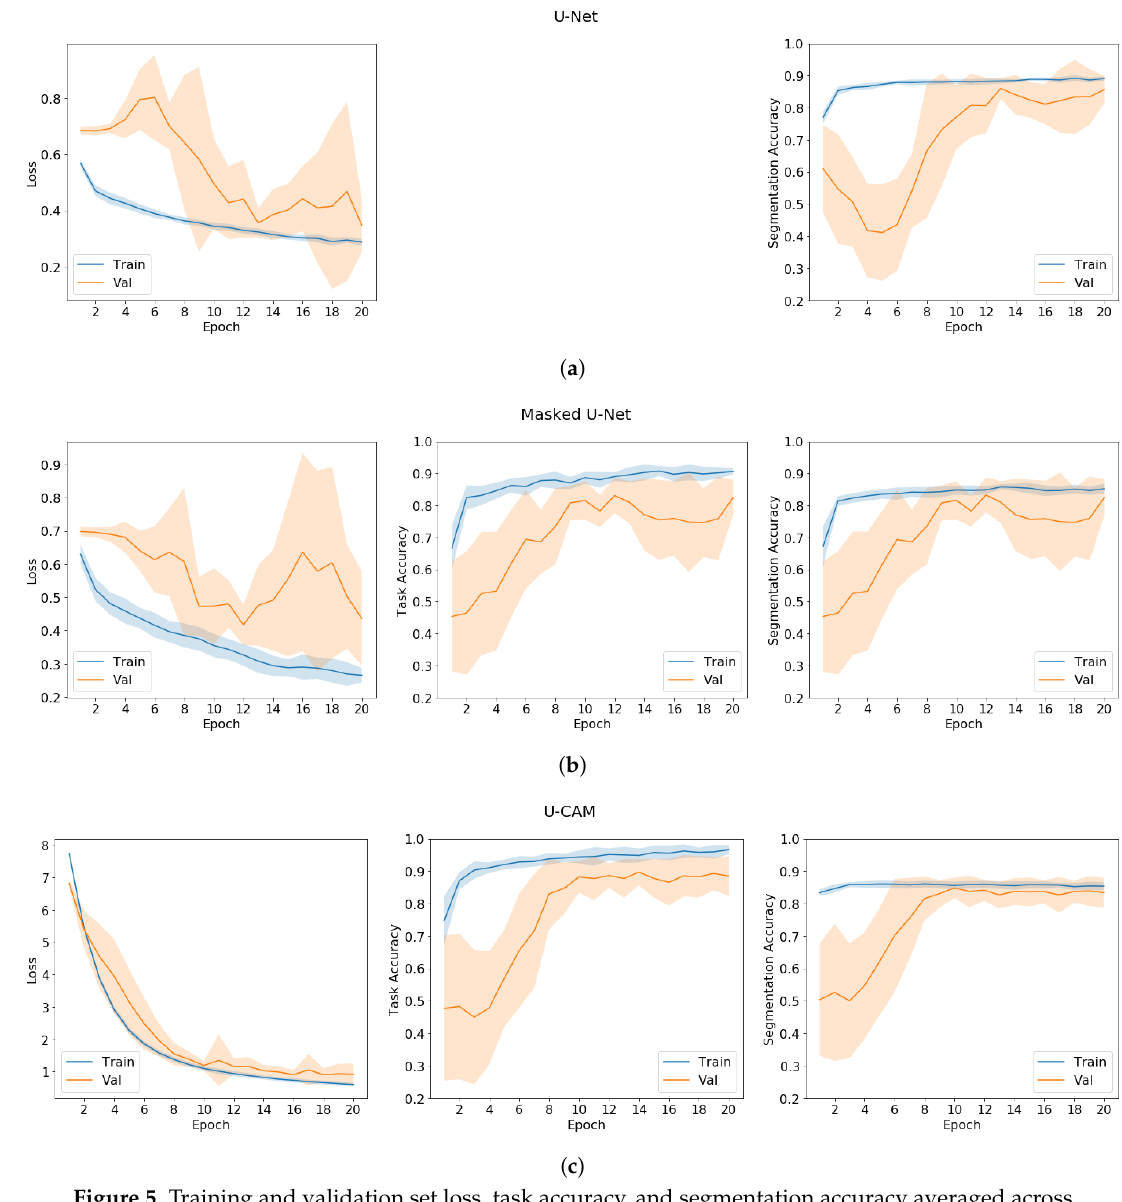
Figure 5. Training and validation set loss, task accuracy, and segmentation accuracy averaged across 10 runs of 20 epochs at n = 200 for the ( a ) U-Net, ( b ) masked U-Net, and ( c ) U-CAM models. The “task” refers to single pixel classification for the masked U-Net and image classification for the U-CAM model. The U-Net does not perform a proxy task, so it has no middle panel. One standard deviation error bars are shown in the shaded